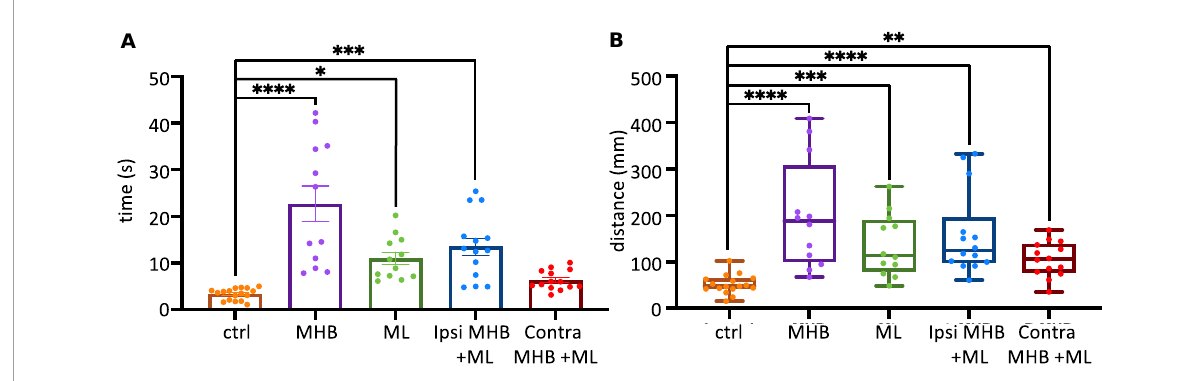
FIGURE6 Midbrain lesions affect sustained swimming. (A) The average duration of swim episodes in control and midbrain lesioned animals. Controls swam for 3.3 ± 0.3 s after stimulation. MHB: 22.7 ± 3.8 s; ML: 11.0 ± 1.3 s; Ipsi MHB + ML: 13.5 ± 1.9 s; Contra MHB + ML: 6.3 ± 0.6 s. Reported as mean ± SEM. Single data points are plotted; the middle horizontal line represents the mean and the extended vertical bars represent the SEM. (B) Controls travelled 47.4, 41.9–63.7 mm (note the size of the arena had a radius of 45 mm). MHB: 187.5, 99.7–307.5 mm; ML: 113.7, 79.4–189.6 mm; Ipsi MHB + ML: 123.9, 97.7–195.7 mm; Contra MHB + ML: 105.8, 77.4–138.3 mm. Sample size identical to those in Figure 5 . For panel (A) Results are reported as mean ± SEM; single data points are plotted, the horizontal line represents mean duration, error bars represent the SEM. For panel (B) Results are reported as median and IQR (25–75 percentile); for boxplot, single data points are plotted, the middle horizontal line represents median distance, the box represents the interquartile range (IQR, 25–75 percentile), and the extended vertical bars represent the minimum and maximum values. ∗∗∗∗ p < 0.0001, ∗∗∗ p < 0.001, ∗∗ p < 0.01 and ∗ p < 0.05 for ANOVA/Dunnett’s and Kruskal-Wallis/Dunn’s